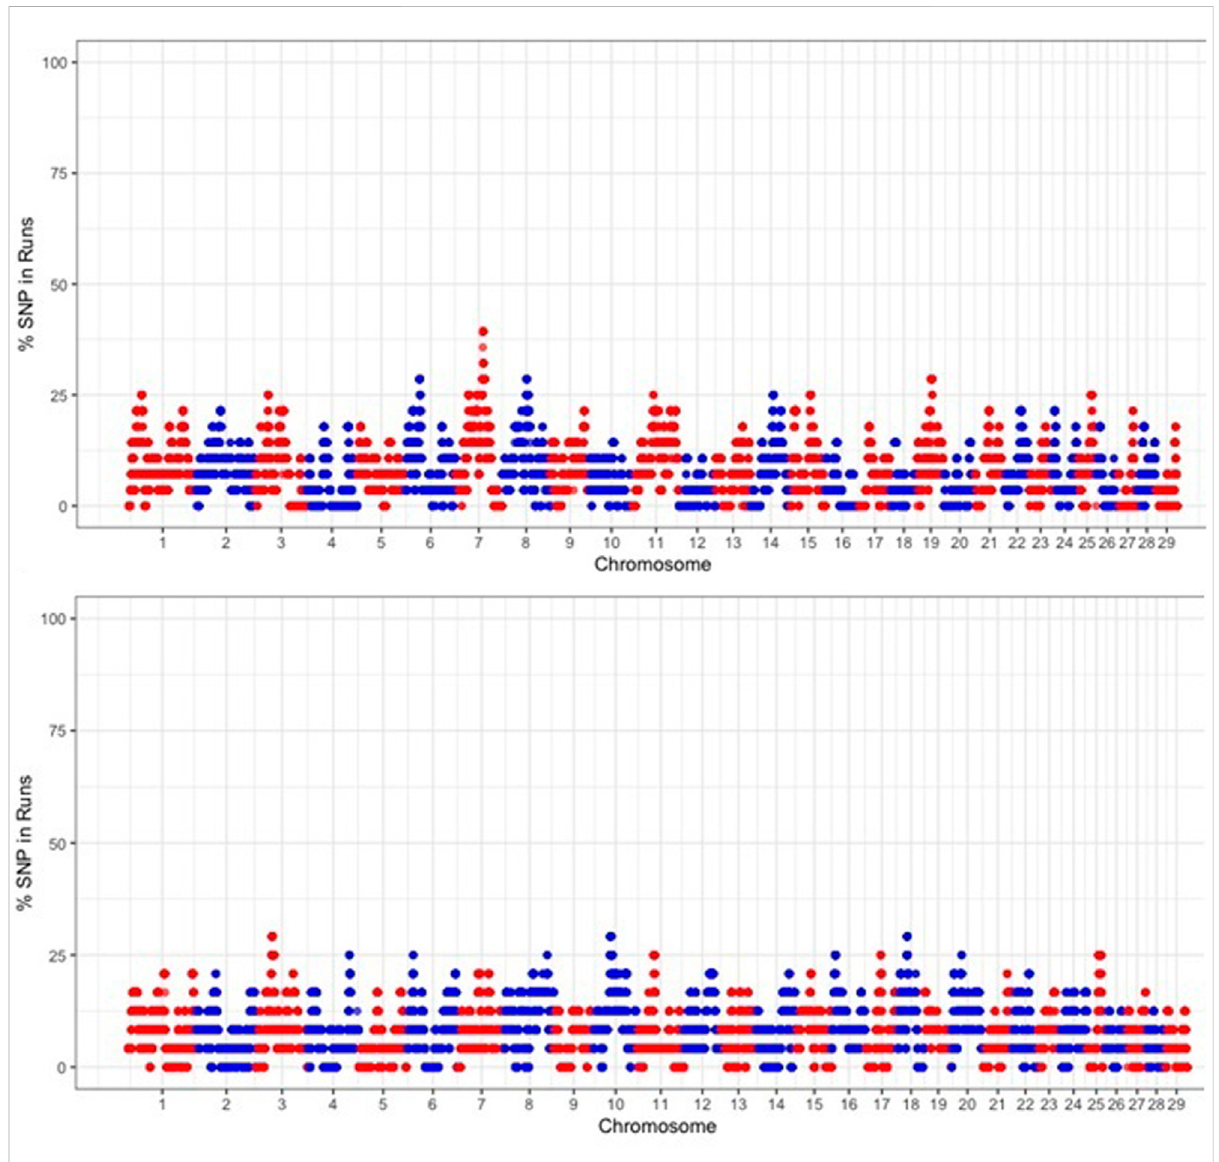
FIGURE 7 Manhattan plot of occurrences (%) of a SNP in ROH across